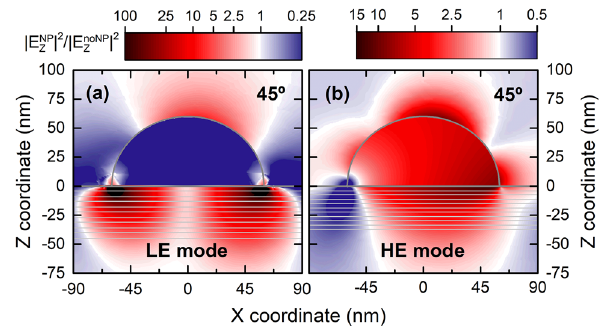
Figure 5: Enhancement of the squared z -component of the electric fi eldinMQWs,de fi nedastheratioof | E | 2 withandwithoutNPs,at45 ° . z (a) LE resonant MQWs. (b) HE resonant MQWs. The 5 × alternating barrier-QW periods are represented below the NP base.